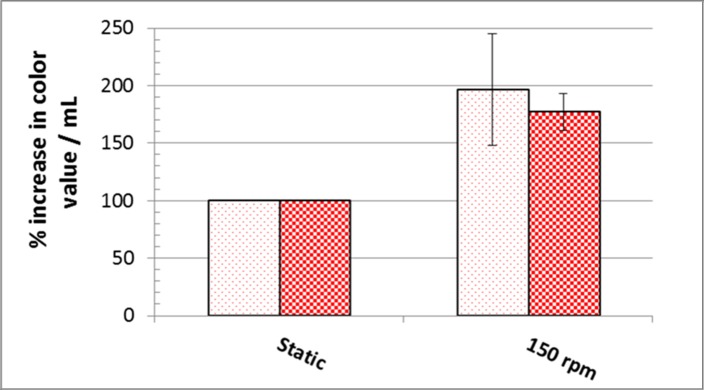
Effect of aeration on orange and red monascus pigments production.Dotted bars: orange moanscus pigments. Checkboard bars: red monascus pigments.